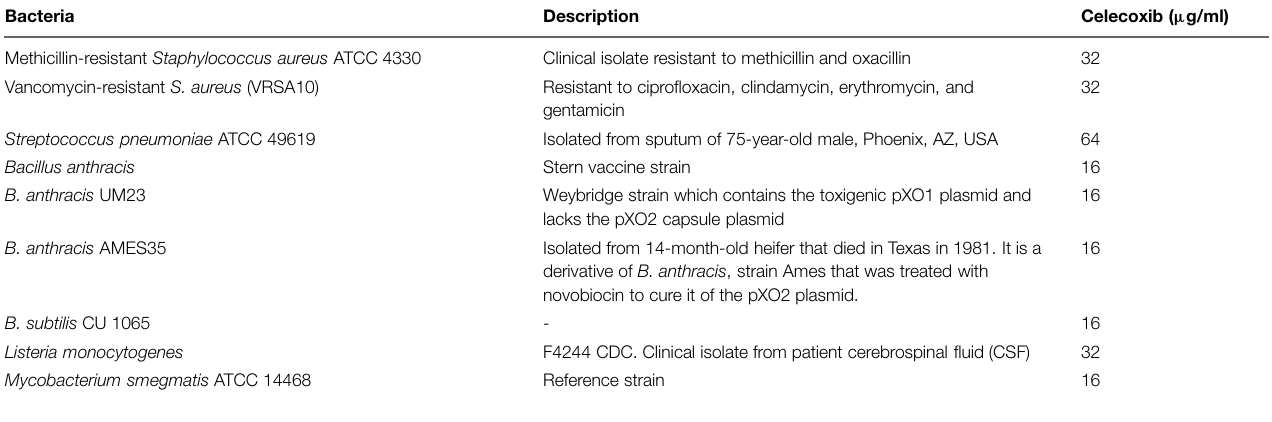
TABLE 1 | Minimum inhibitory concentration (MIC) of celecoxib against Gram-positive bacteria. Bacteria Description